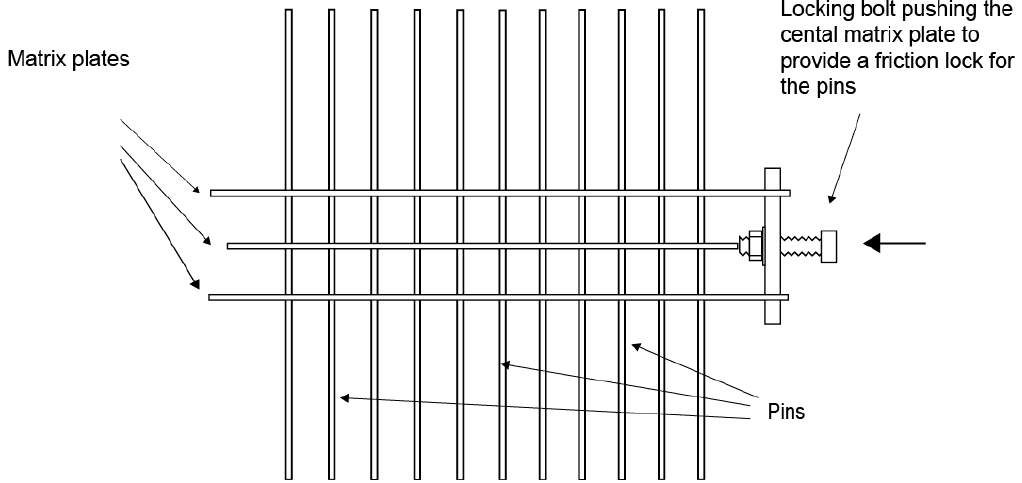
Figure 3. Early RPT friction lock principle used by the author in the initial experiments with the square format pin tool, (illustration: Jorgensen, T. 2011).